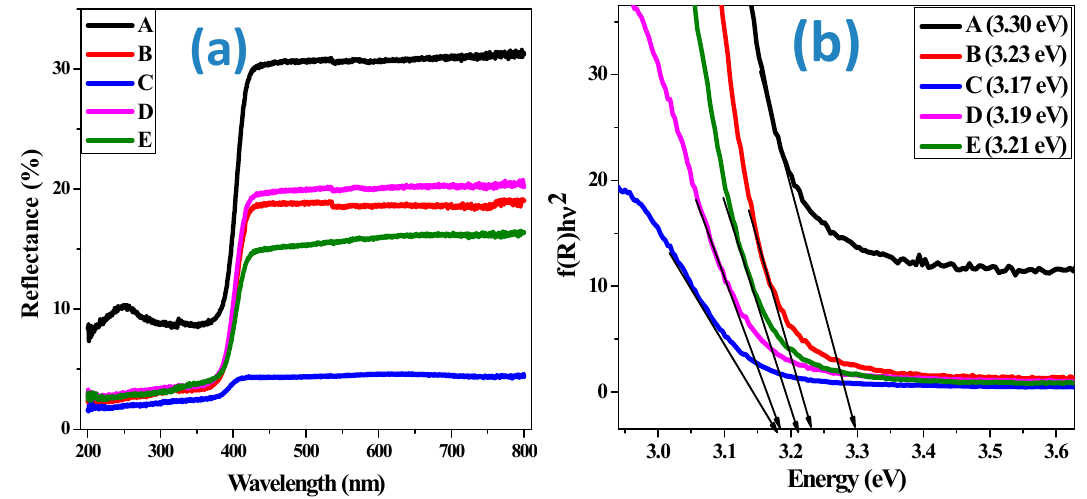
Figure 6. ( a ) Diffuse reflectance spectra of NiO samples. ( b ) Optical energy gap spectra of NiO samples.